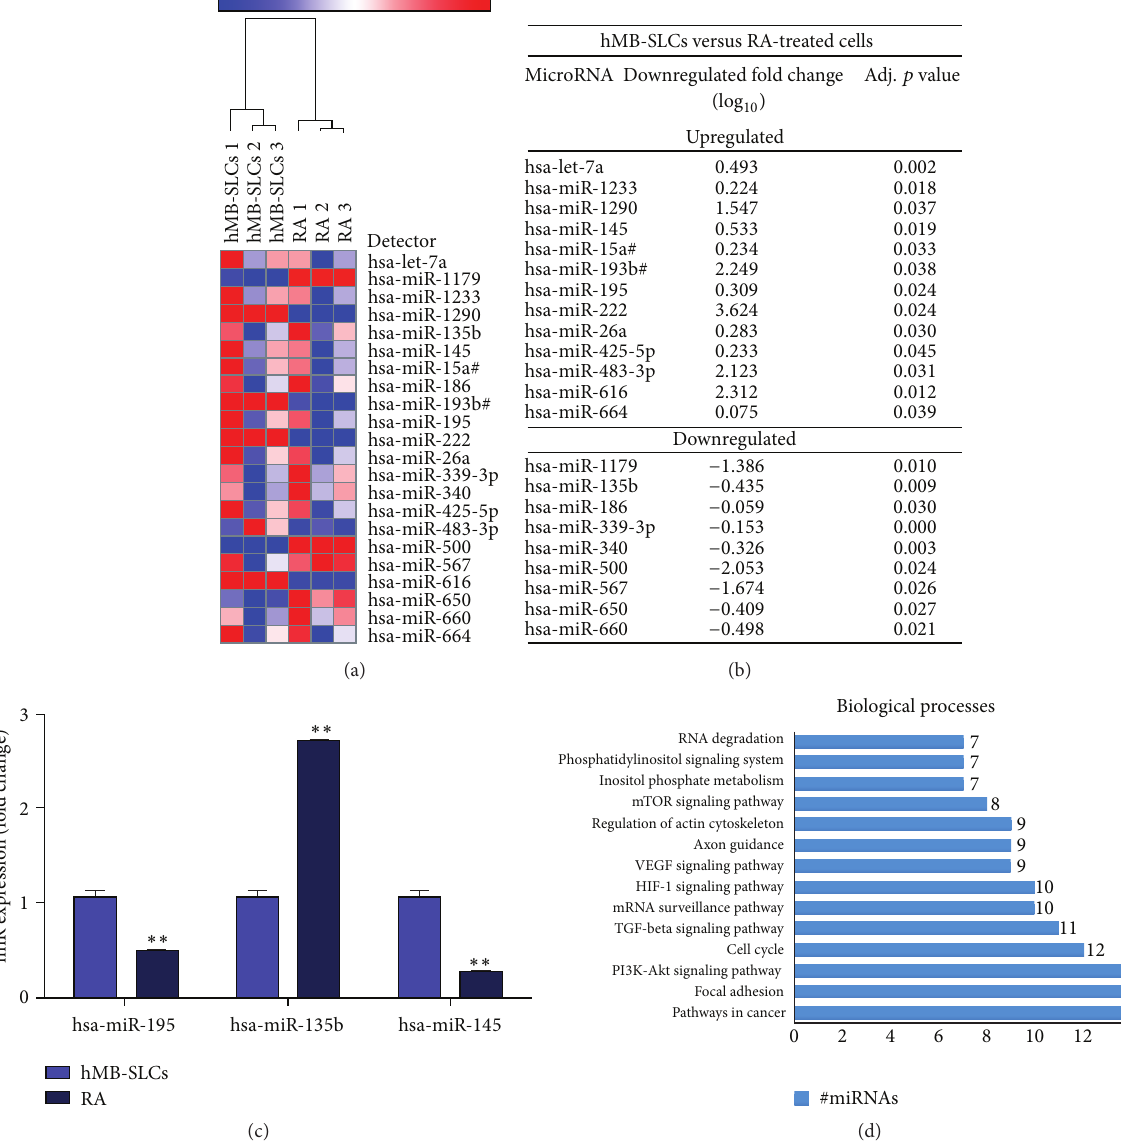
Figure 3: MicroRNA profiling of hMB-SLCs and RA-treated cells and qPCR validation. (a) Heatmap with unsupervised hierarchical clustering was obtained for hMB-SLCs and their differentiated counterparts. Dendrogram which represents the results of the hierarchical clustering analysis distinguishes hMB-SLCs from RA-treated ones. (b) Significantly up- or downregulated microRNAs in hMB-SLCs versus RA-treated cells with the respective fold change and 𝑝 values are reported. (c) Single qPCR analysis of miR-195, miR-135b, and miR-145 was conducted. MicroRNAs expression levels are expressed as fold change with respect to hMB-SLCs. ∗∗ denotes 𝑝 < 0.01 versus